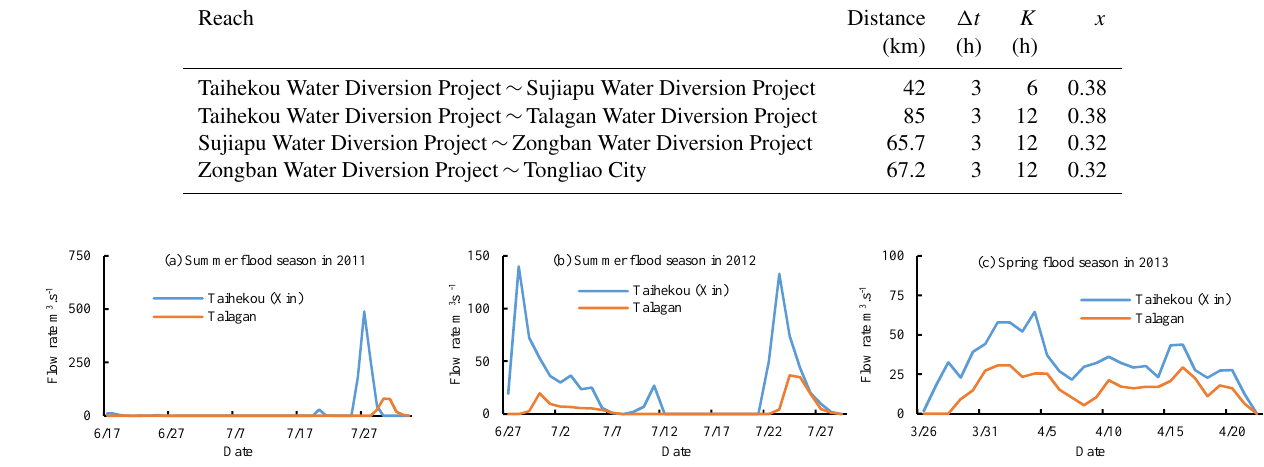
Table 2. The parameters of river flow evolution in West Liaohe River Plain. Reach